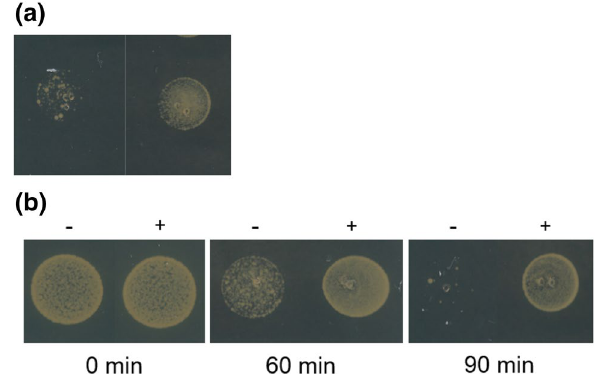
Figure 3. Transient induction of reduced vancomycin susceptibility by LL-37. ( a ) Cultures of S. aureus FPR3757 were grown without (left) or with (right) 10 μg/ml LL-37 for 10 min and spotted on vancomycin plates (1.5 μg/ml). ( b ) Cultures of S. aureus FPR3757 were grown with 10 μg/ml LL-37 for 60 min and LL-37 was removed from the medium in a subset of the culture (left), while exposure to LL-37 was maintained in the other subset (right). After 0, 60 and 90 min, the cultures where plated on agar plates containing vancomycin (1.5 μg/ ml).